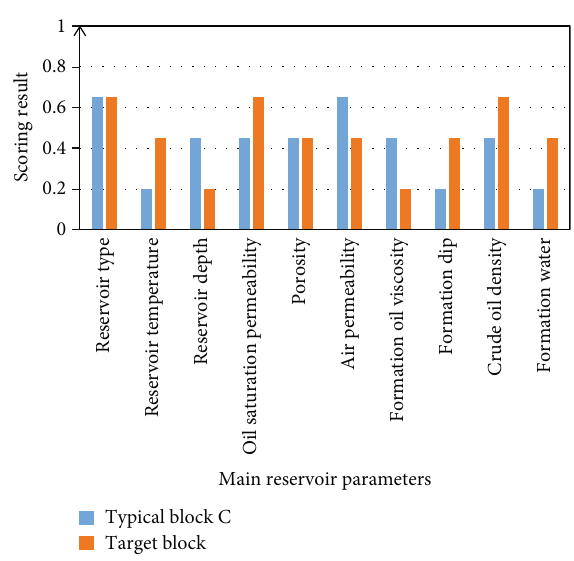
Figure 5: Scoring results of main reservoir parameters of target block and typical block C under polymer fl ooding